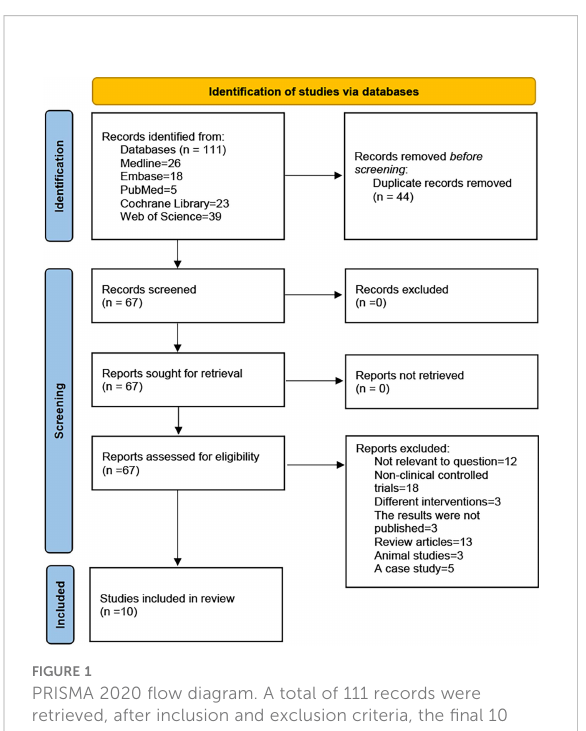
FIGURE 1 PRISMA 2020 fl ow diagram. A total of 111 records were retrieved, after inclusion and exclusion criteria, the fi nal 10 studies were